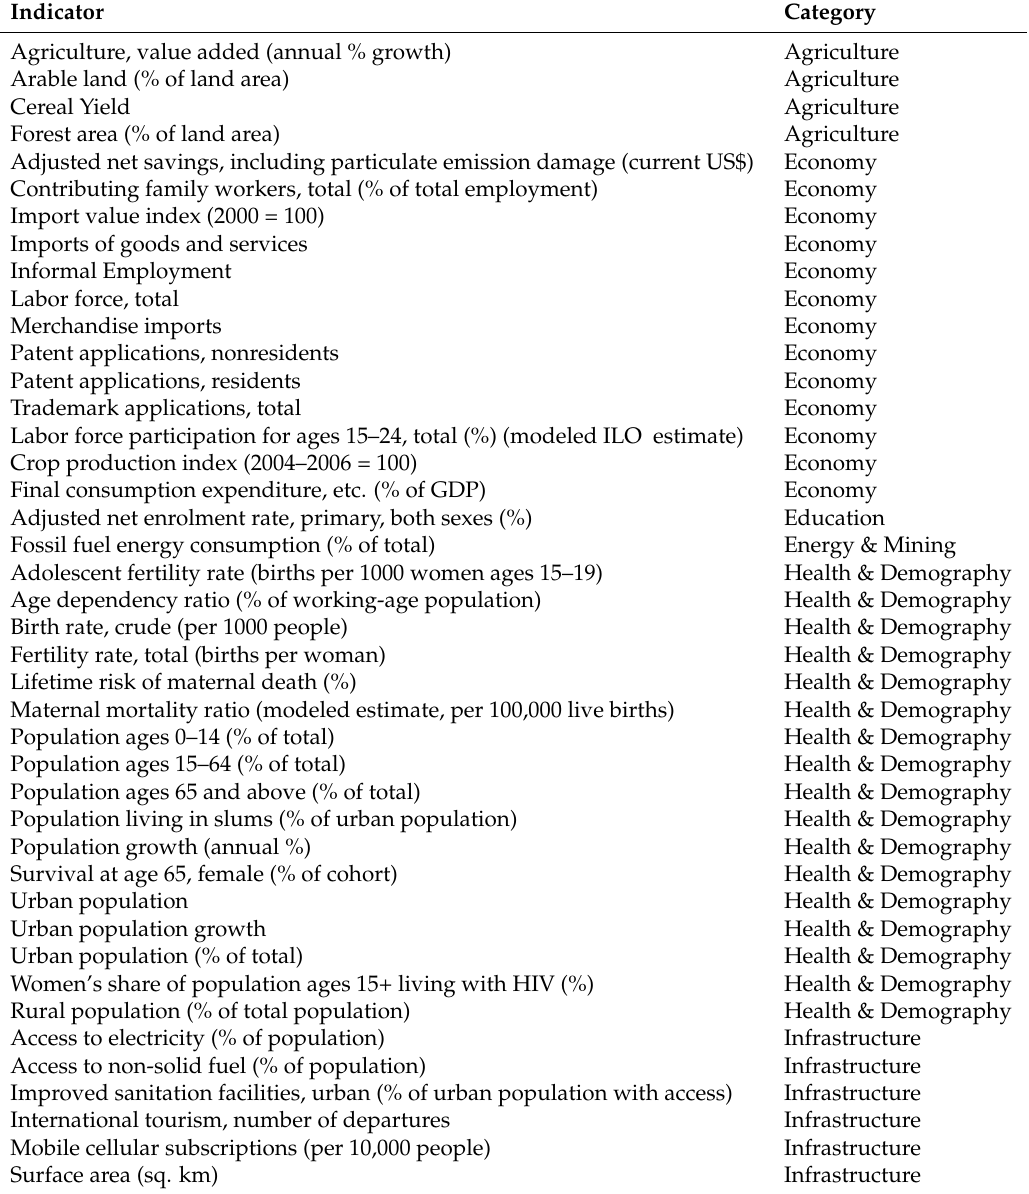
Table A1. All World Development Indicators explicity mentioned in this paper with categories (2016)